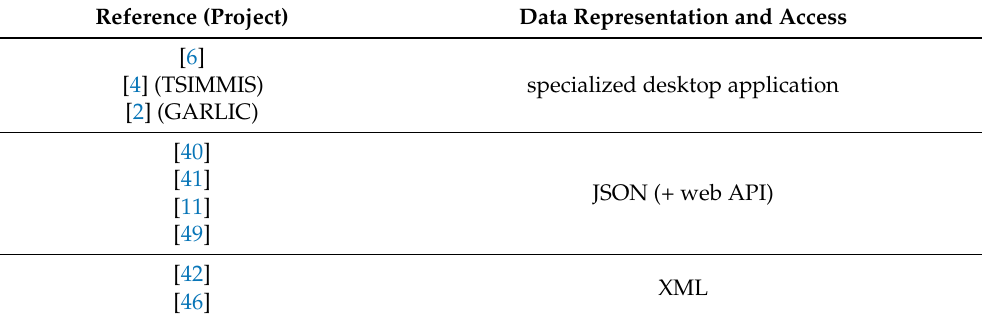
Table 1. Overview of existing data management concepts and projects in regards to their data repre-